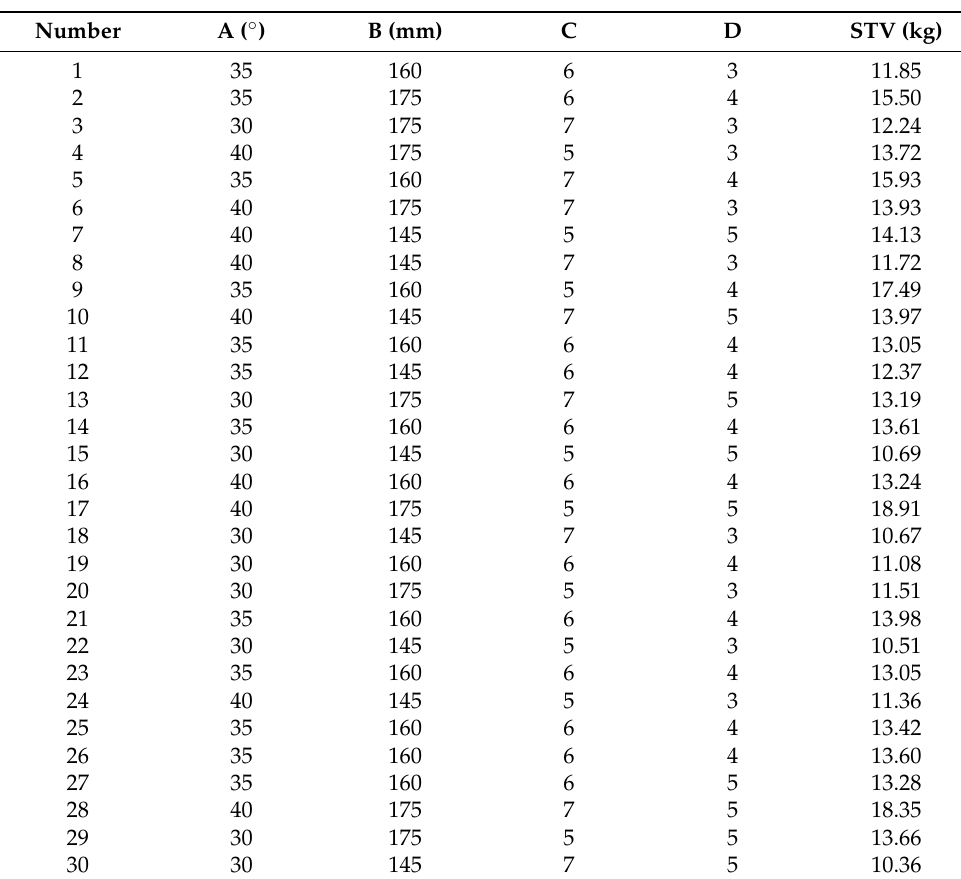
Table 5. Response surface design scheme and response value test